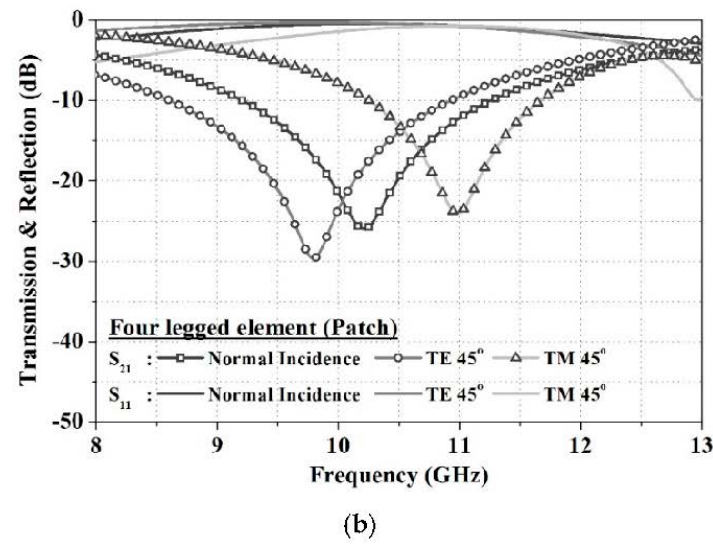
Figure 3. Simulated transmission and reflection results of frequency selective surface (FSS): ( a ) Loop type; ( b ) Patch type.